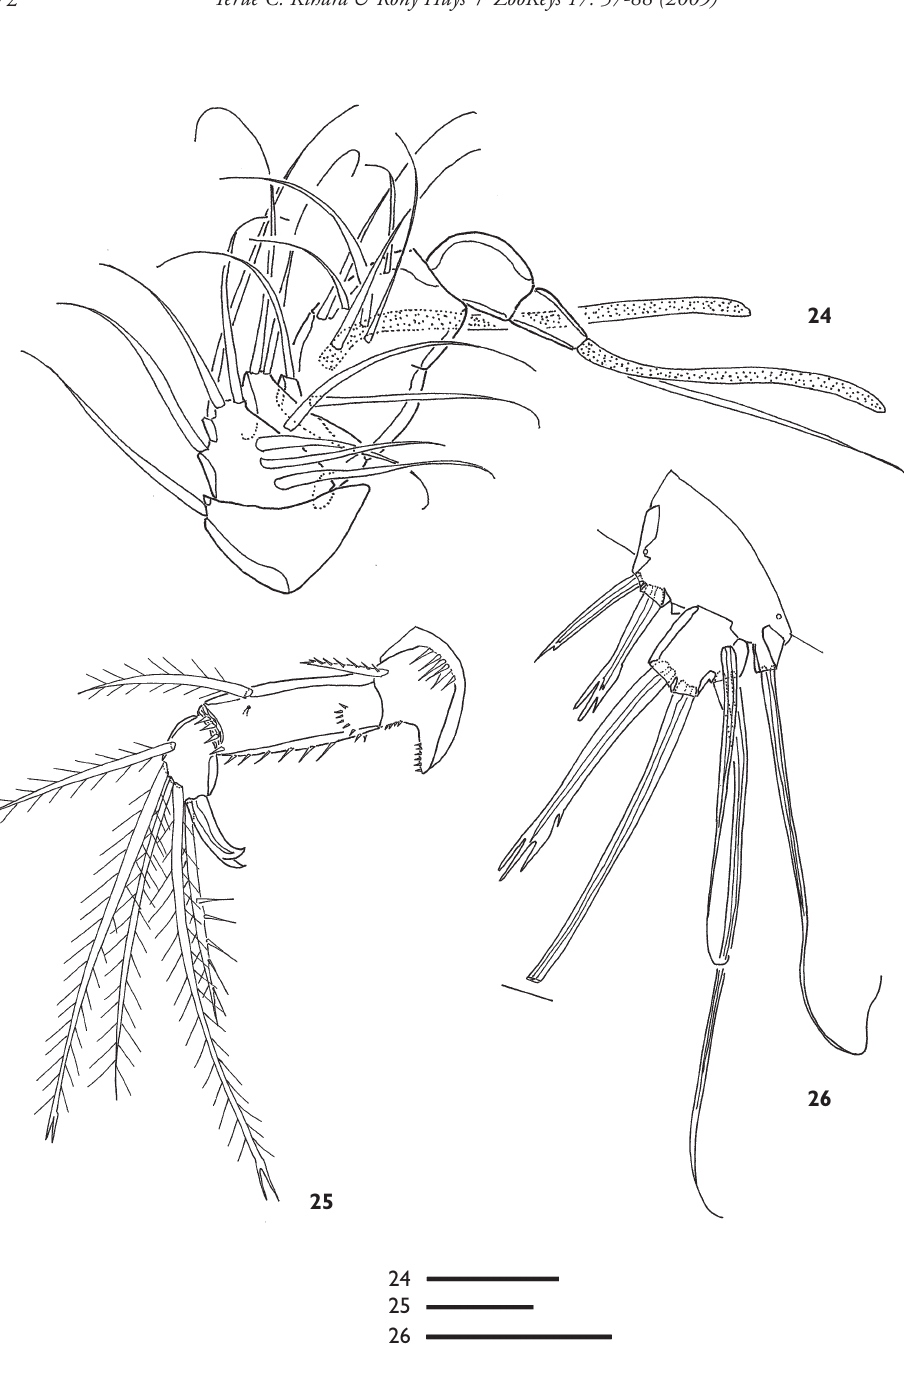
Figures 24-26. Chaulionyx paivacarvalhoi gen. et sp. n. ♂ : 24 antennule, dorsal 25 P1 basis and endo- pod, anterior 26 P5, anterior. Scale bars = 10